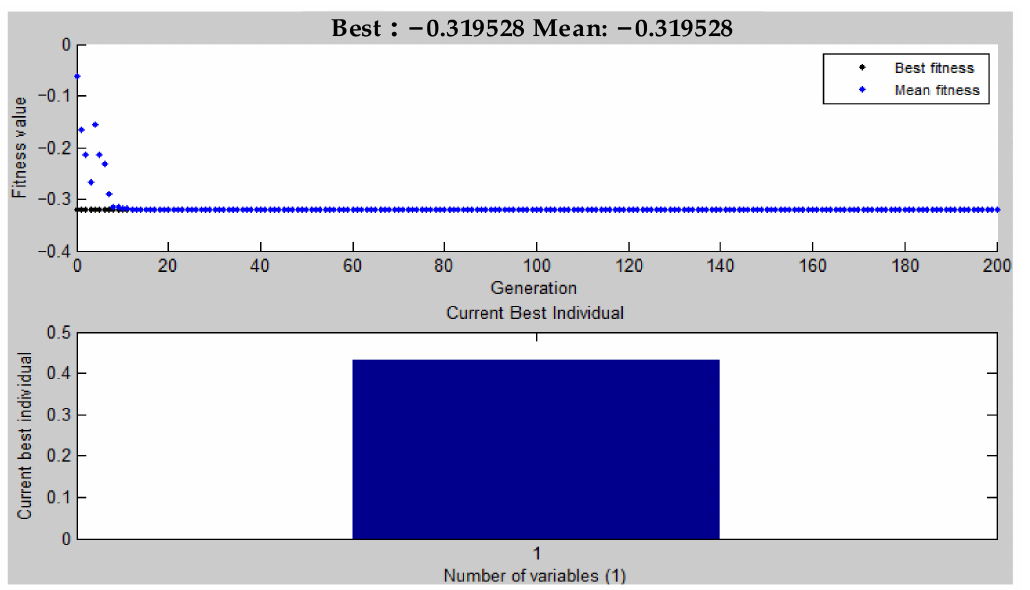
Figure 21. Genetic algorithm iterative